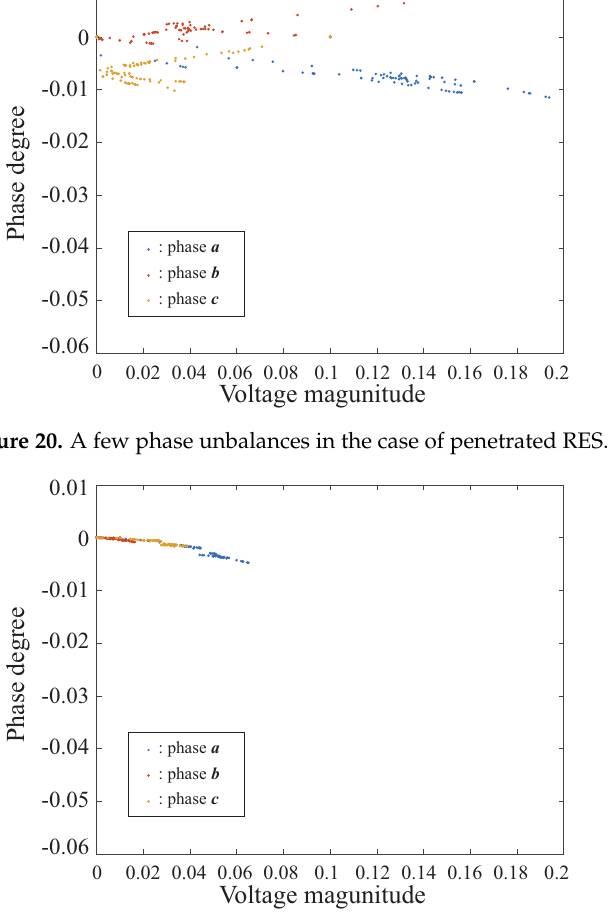
Figure 21. Improved three-phase unbalanced voltage. Table 1. Three-phase voltage unbalance